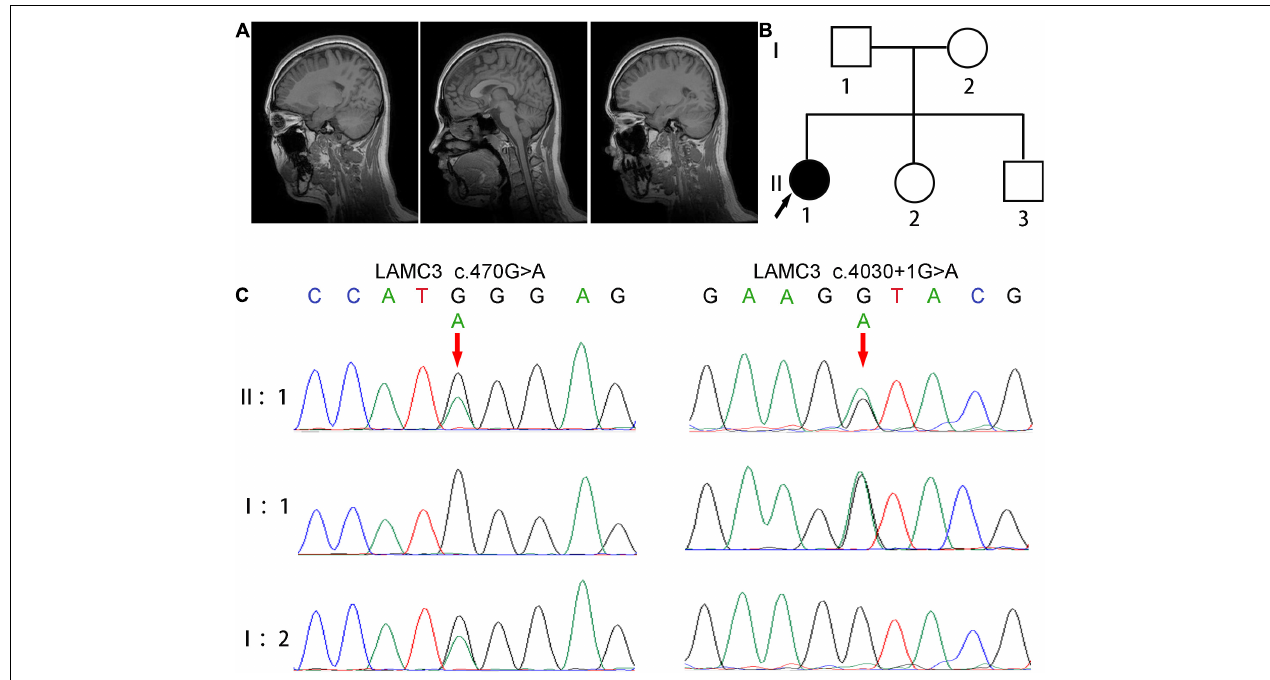
FIGURE 1 | Clinical and genetic characterizations. (A) Cranial MRI showed normal brain structure without abnormal signal and lateral ventricular dilation. (B) The pedigree of this family shows only the patient had epilepsy, and her parents and two younger siblings were both unaffected. (C) Direct polymerase chain reaction sequencing revealed a heterozygous variant c.4030 + 1G > A on exon 24 of the father’s LAMC3 gene, and a heterozygous variant c.470G > A on exon 2 of the mother’s LAMC3